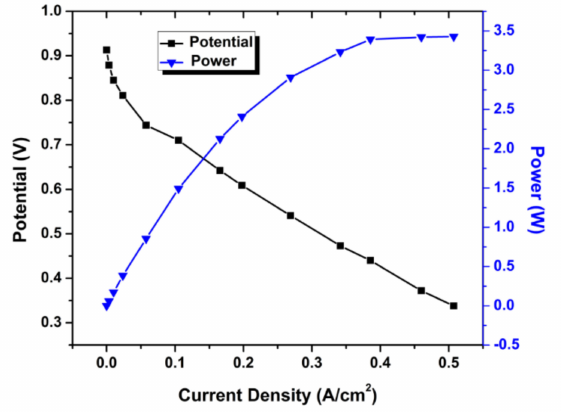
Figure 7. Fuel cell